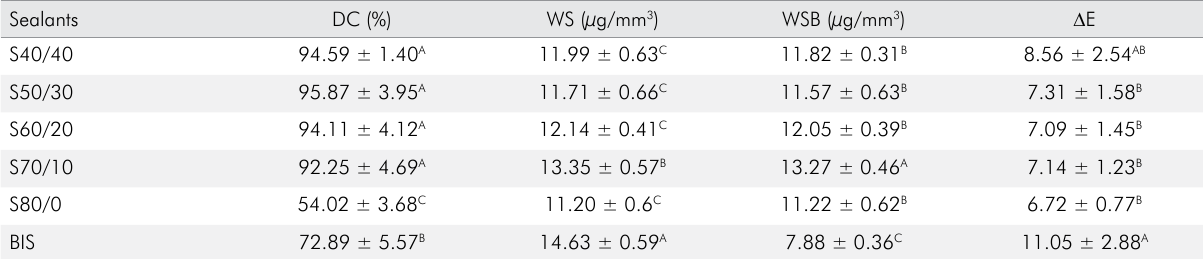
Table 2. Mean (±Standard Deviation; SD) of degree of conversion (DC), water sorption (WS) and water solubility (WSB), according to the groups.